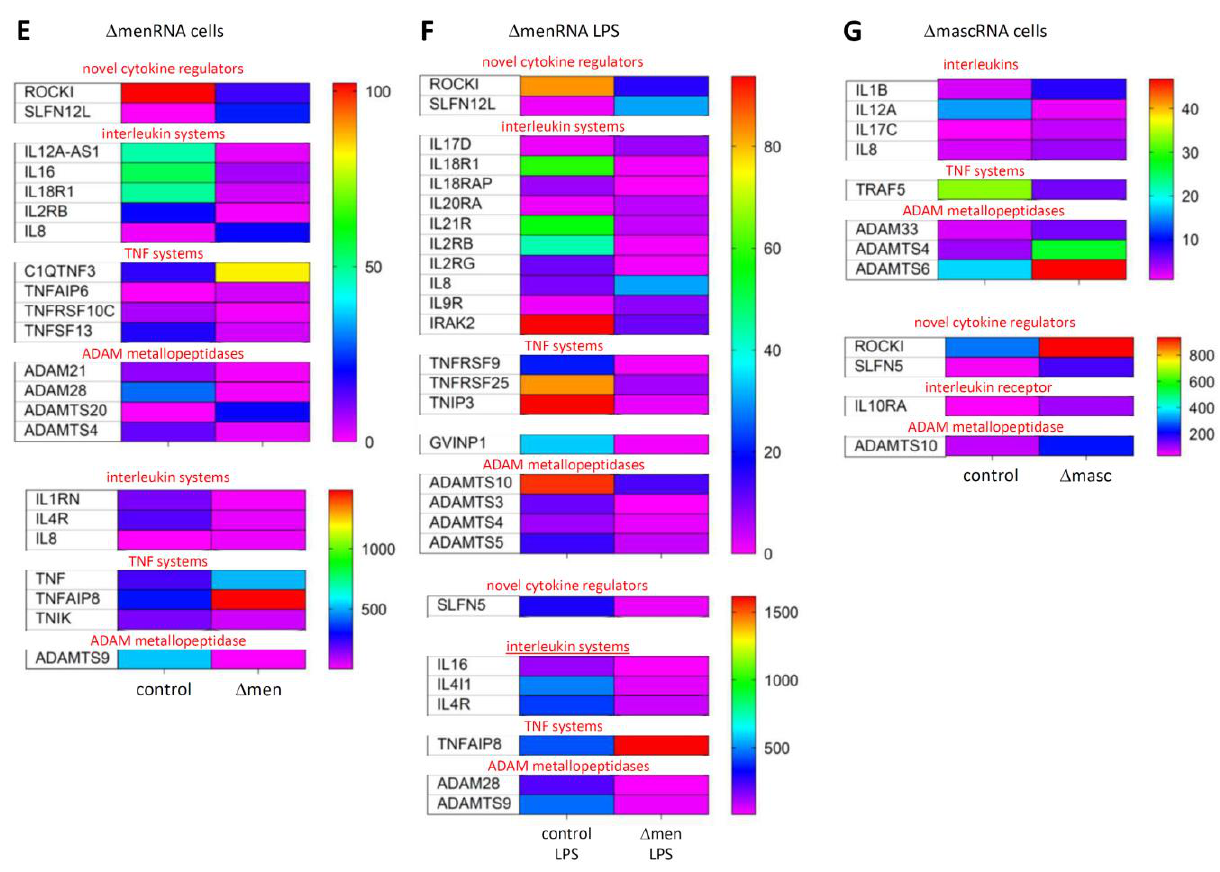
Figure 4. menRNA and mascRNA deletion results in loss of cytokine control and imbalance of interleukin systems. Panel ( A ): A prominent finding was the massively elevated expression and secretion of IL-8, TNF, and IL1B in unstimulated ∆ menRNA cells. Cytometric bead assay protein data on media conditioned by control monocytes (green), ∆ menRNA (orange), and ∆ mascRNA cells (red). Panel ( B ): qRT-PCR quantification of gene expression levels. For all three proinflammatory cytokines, ∆ menRNA displayed far more pronounced induction than ∆ mascRNA cells. Panel ( C ): ∆ mascRNA monocytes displayed exaggerated induction of IL1A, IL1B, IL10, and ISG15 expression upon LPS-stimulation as compared to controls. Only stimulated ∆ menRNA cells showed a further increase of IL8 expression, whereas IL16 [38] was suppressed in this clone at baseline and failed to become induced upon LPS challenge. Panel ( D ): Partial “rescue” of cytokine control in ∆ menRNA cells by recombinant human menRNA expressed from the adenovector Ad5-menRNA (without CCA terminus) described in Figure 1H. RR5 is an “empty” control vector without an expression cassette (means ± SD of triplicate measurements) (* denotes p < 0.05, ** p < 0.01, *** p < 0.001). Panels ( E , F ): RNA-seq identified further anomalies of IL and TNF systems. The color bars associated with the rainbow plots in panels ( E – G ) represent FPKM values. Among receptors, IL4R was ~7-fold- and IL4-induced gene (IL4I1) ~11-fold-suppressed in stimulated ∆ menRNA cells (panels ( E , F )). Even more pronounced was disequilibrium in the IL18 system (IL18R1 > 70-fold inhibited, IL18 receptor accessory protein IL18RAP switched off). In the IL2 system, receptor subunit IL2R- β was ~52-fold- and IL2R- γ ~13-fold-suppressed in LPS-stimulated ∆ menRNA monocytes (panel ( F )). Regarding the IL1 system, IL1 receptor antagonist IL1RN was ~12-fold and IL1 receptor-associated kinase IRAK2~8- fold down in ∆ menRNA cells. Among the ligands, IL16 expression remained ~18-fold-blunted even upon LPS-challenge (compare panel ( C